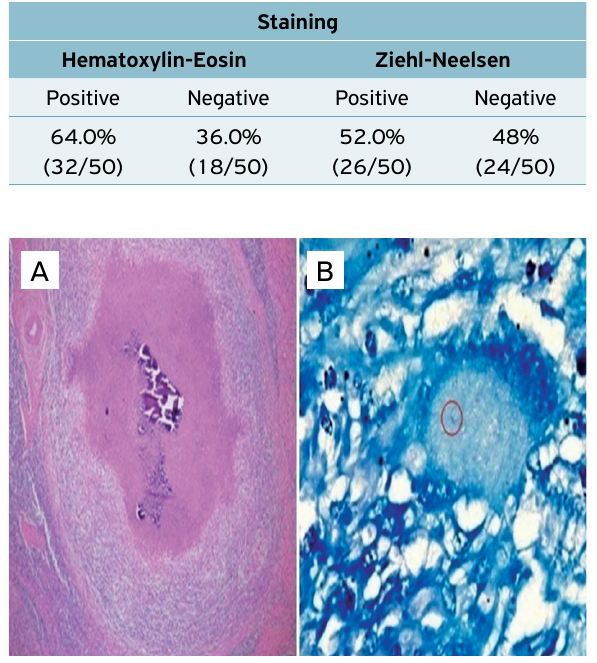
Figure 3. (A) Typical tuberculosis granuloma with central area of dystrophic calcification, necrosis, surrounded by inflammatory infiltrate composed mainly of macrophages. HE staining, 4‑fold increase. (B) Histological section showing AFB (circled) inside the cytoplasm of a Langerhans type cell. ZN staining, 100‑fold increase.